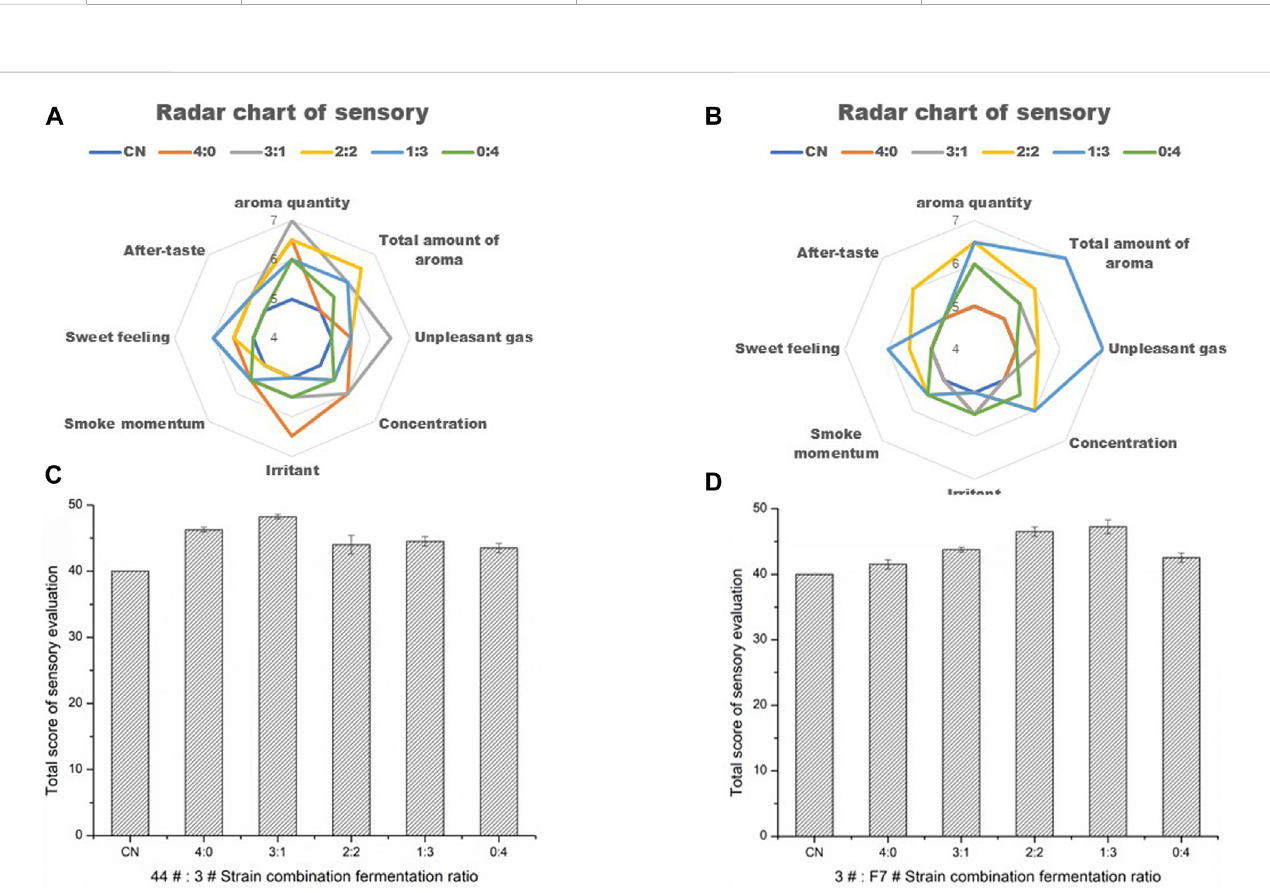
FIGURE 6 Optimizationand sensory evaluation results of combined strains (A) . The qualityimprovement effect of strains 44# and 3# combined was different from that of individual strains (B) . The combined effect of strains F7# and 3# was different from that of the individual strains (C) . Optimization of the ratio of strains 44# and 3# (D) . Optimization of the ratio of strains F7# and